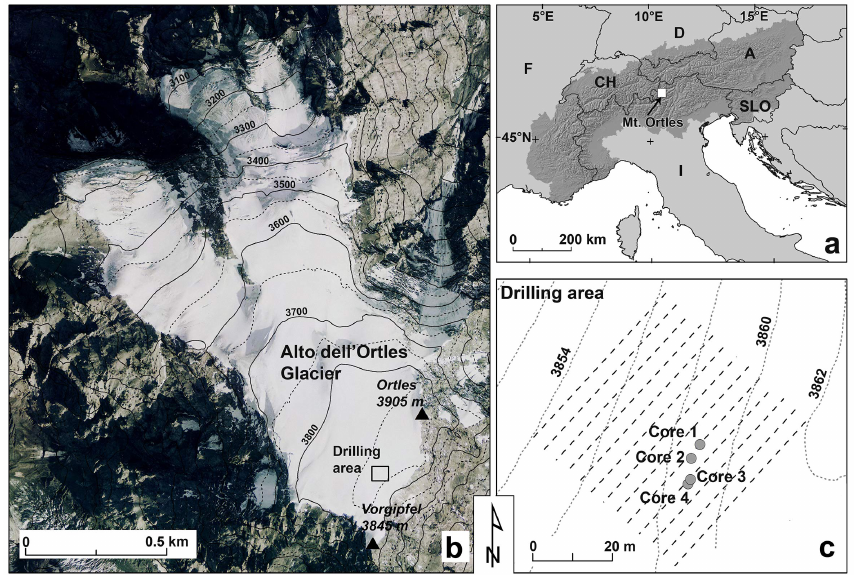
Figure 1. (a) Geographic location of Mt. Ortles. (b) Map of the Alto dell’Ortles glacier (South Tyrol, Italy), including the area (box) where the drilling operation was conducted during September–October 2011. (c) Detailed map of the drilling site, including (i) the specific locations where the four cores were extracted and (ii) the traces of the detailed ground penetration radar (GPR) survey performed in July